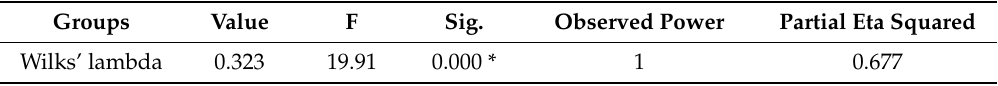
Table 7. Comparison of HRT and HS scores across